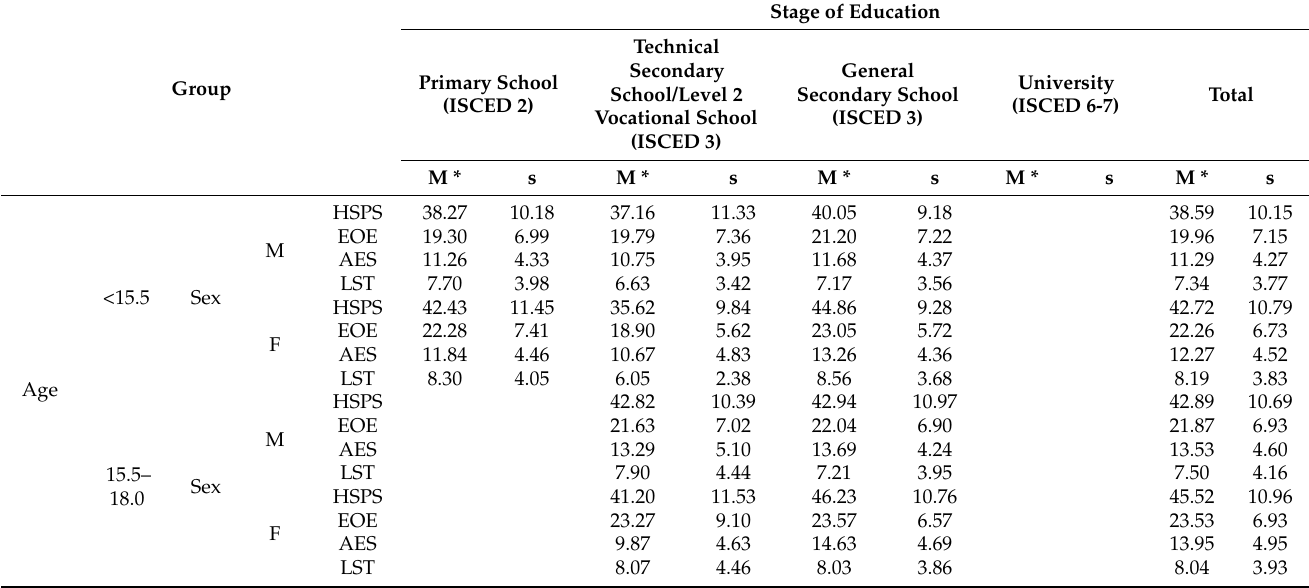
Table 4. HSPS-10 scale scores in different groups among study